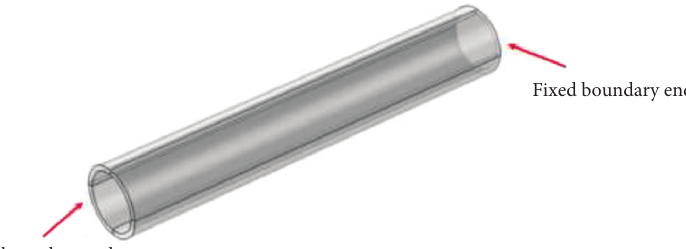
Figure 8: Fixed-fixed boundary fundamental frequency analysis (both the ends are